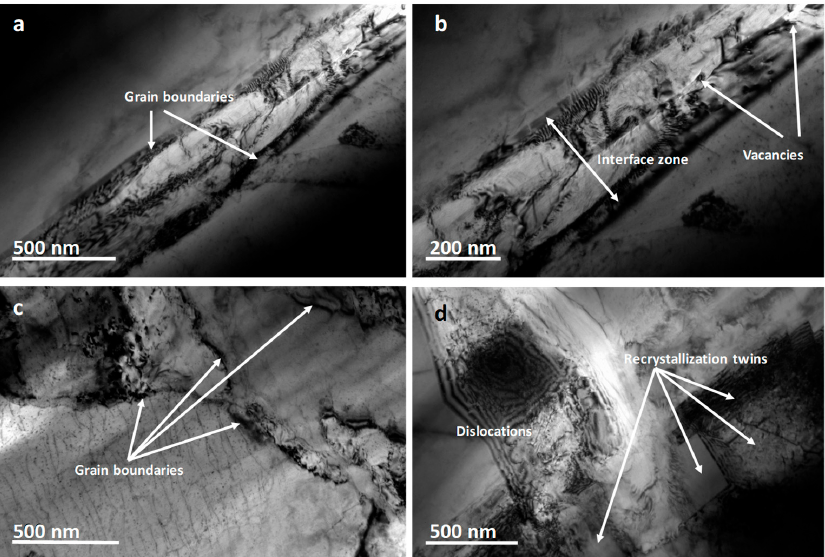
Figure 6. Transmission electron microcopy images in bonding zone applied in grains with different size: ( a , b ) grain size 100–200 μ m, ( c , d ) grain size ≤ 50 μ m.